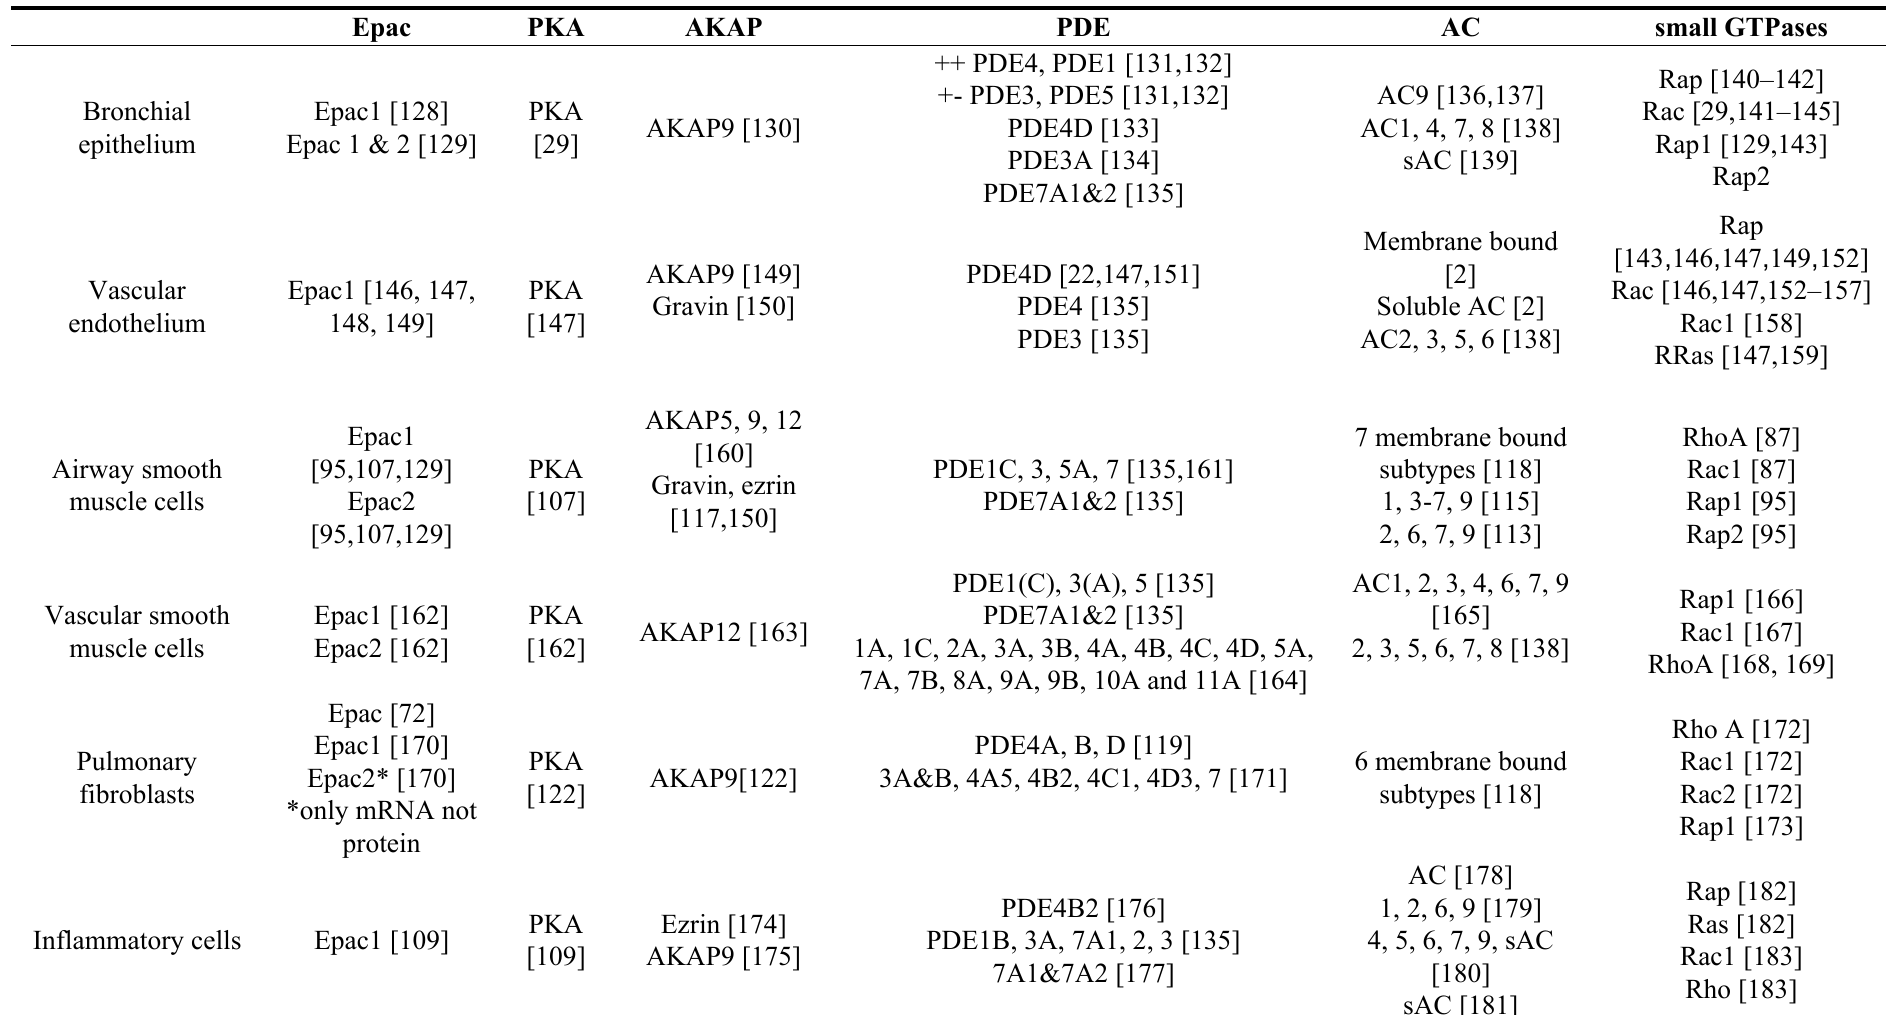
Table 1. Expression of elements of cAMP signalling in cells and tissues involved in the pathogenesis of lung